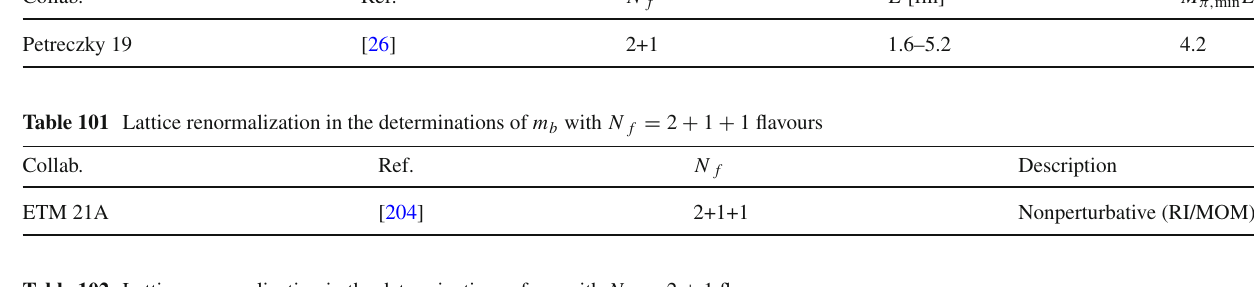
Table 102 Lattice renormalization in the determinations of m b with N f = 2 + 1 flavours Collab.